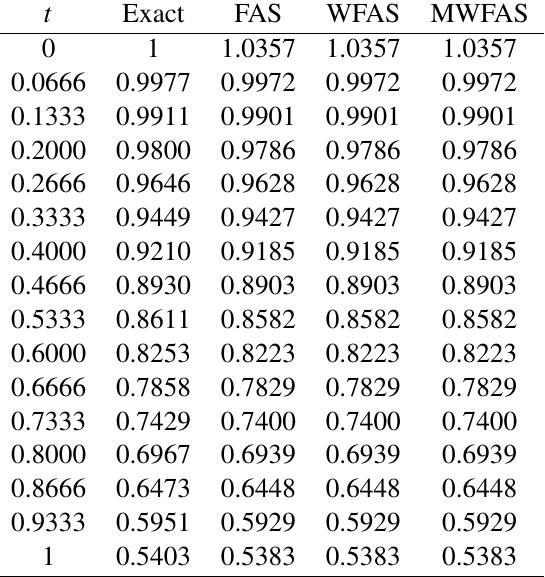
Table 5 Numerical results of test problem 5.3, for N = 16